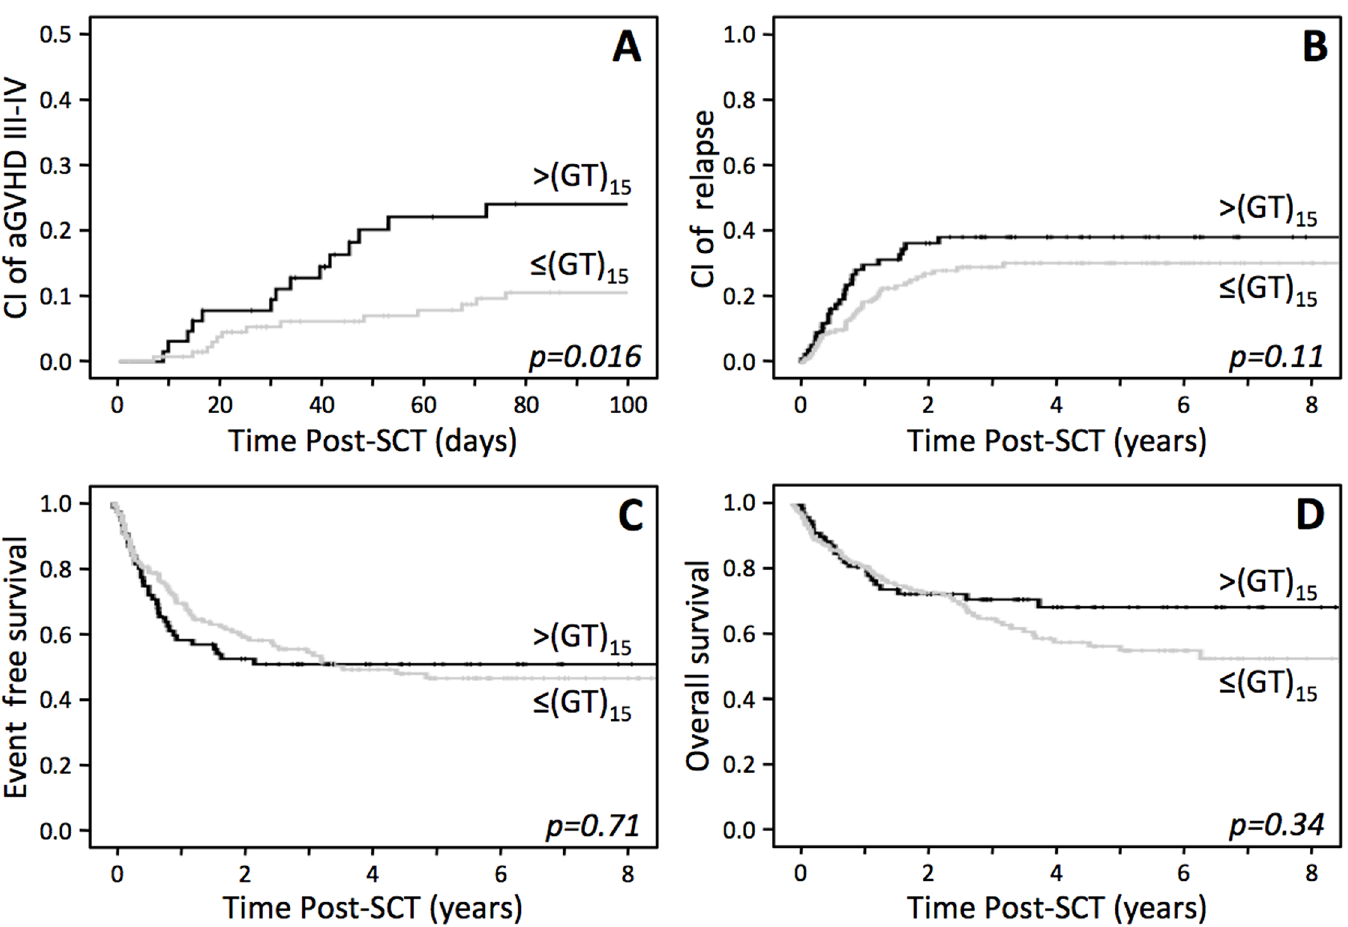
Fig 2. Influence of the genotype of the donor for the polymorphism (GT) n in the promoter/enhancer of FOXP3 on the outcome of allo-SCT. (A) Cumulative incidence of grade III-IV GVHD. (B) Cumulative incidence of relapse. (C-D) Kaplan-Meier curves of event free survival (B) and overall survival